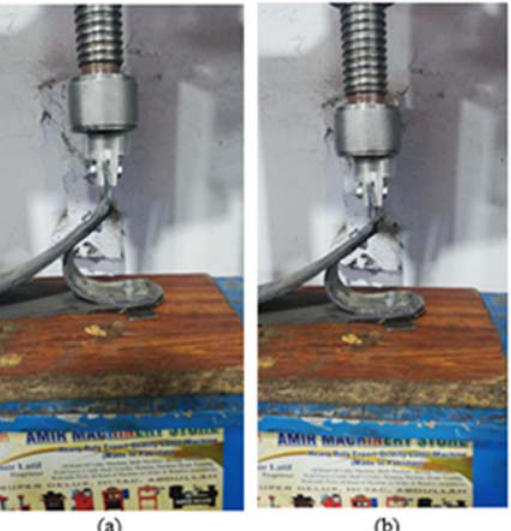
8 of 13 Figure 5. ( a ) Stress–strain curve for two-layered sample (Failed Sample 1) ( b ) Stress–strain curve for four-layered sample (Failed Sample 2). 3.1. Prosthetic Foot Prototype Results The prototype for the prosthetic foot was tested under a static load of 68,948 N/m 2 to check the displacement of footplates. Figure 6a shows the displacement under a load of zero. However, Figure 6b shows the displacement of footplates when a static load (68,498